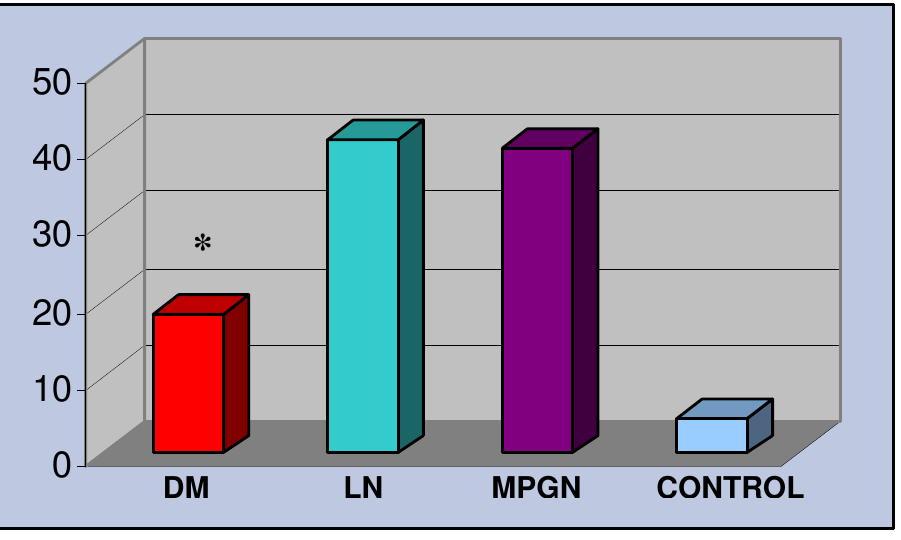
FIGURE 2 . PKC β renal gene expression in the study groups ( µ g/ml). * p < 0.005 compared to LN and MPGN groups.